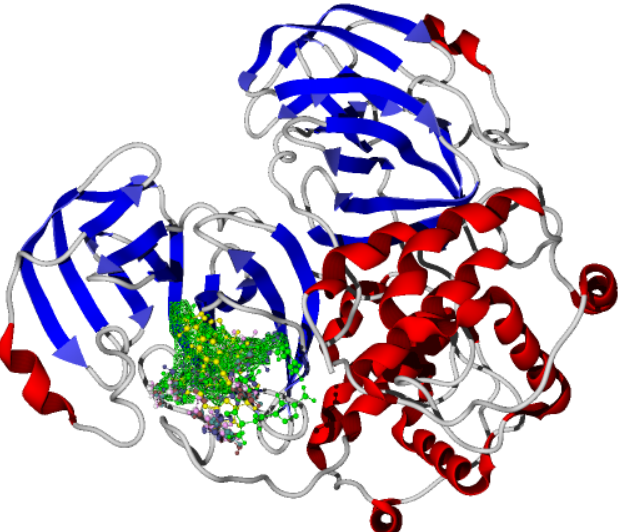
Figure 2. ( a ) 1 H NMR spectrum of the compound 1a , ( b ) 13 C NMR spectrum of the compound 8a .